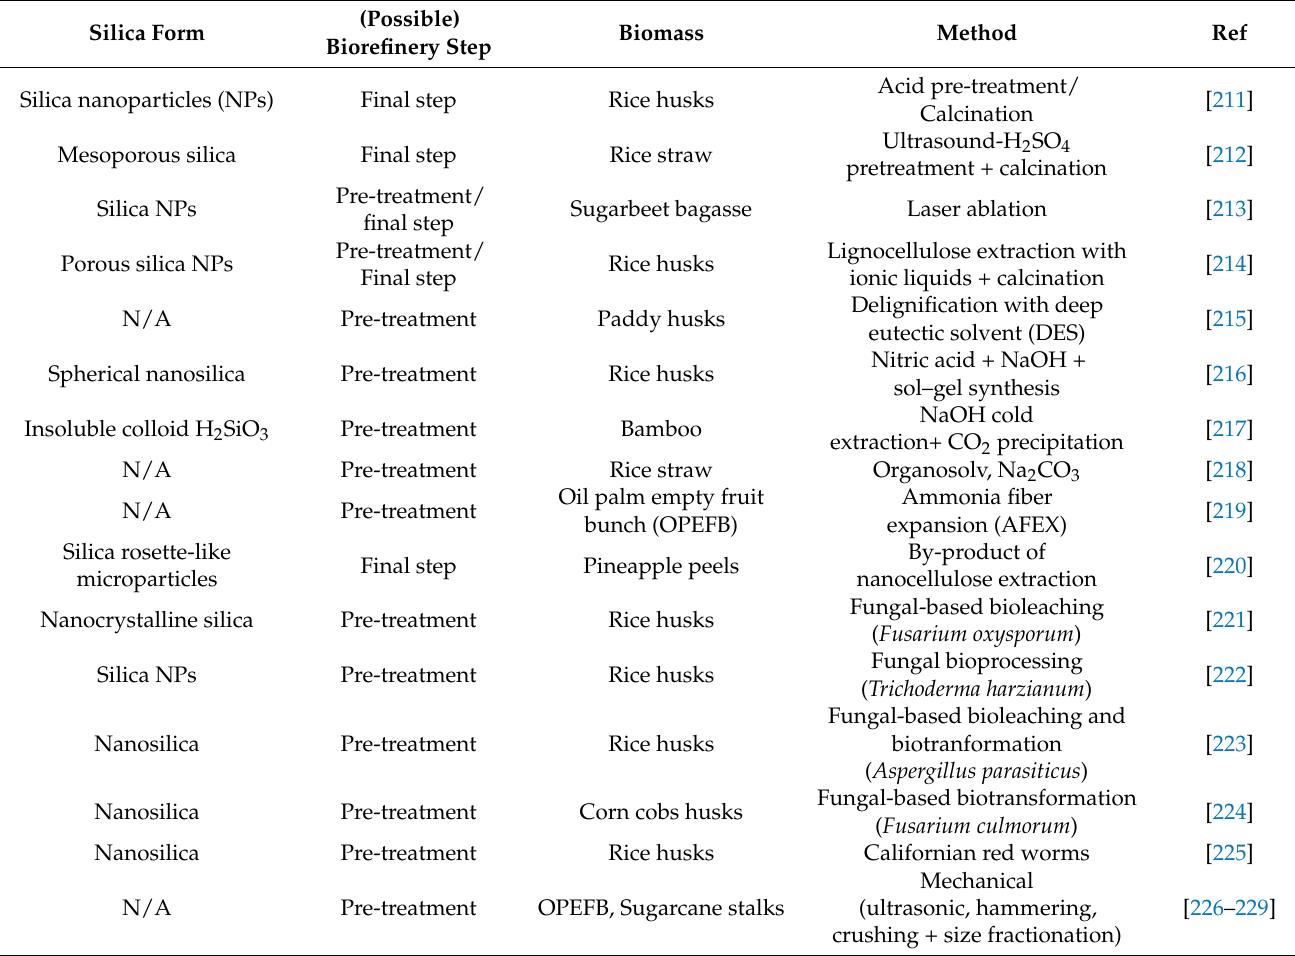
Table 2. Methods described until now for the separation of the biosilica from the biomass of the silicon accumulating